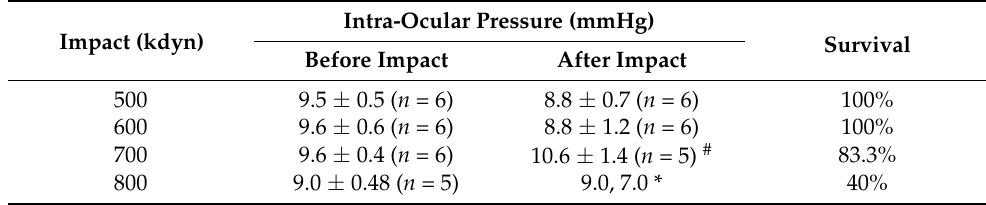
Table 1. Intra-ocular